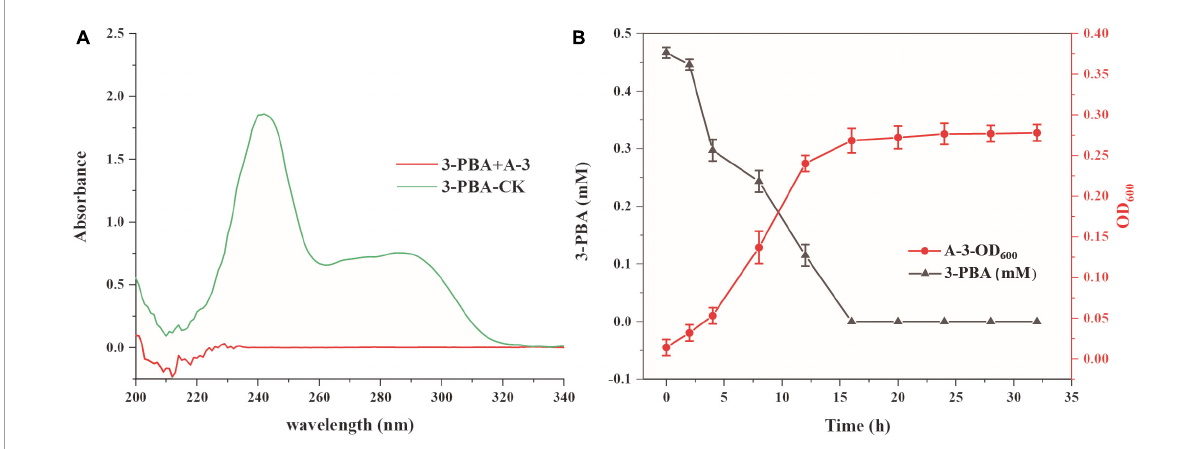
FIGURE4 Degradation of 3-PBA by stain A-3. (A) UV scanning detection of 3-PBA degradation by strain A-3; (B) time course curve of 3-PBA degradation and growth of A-3.